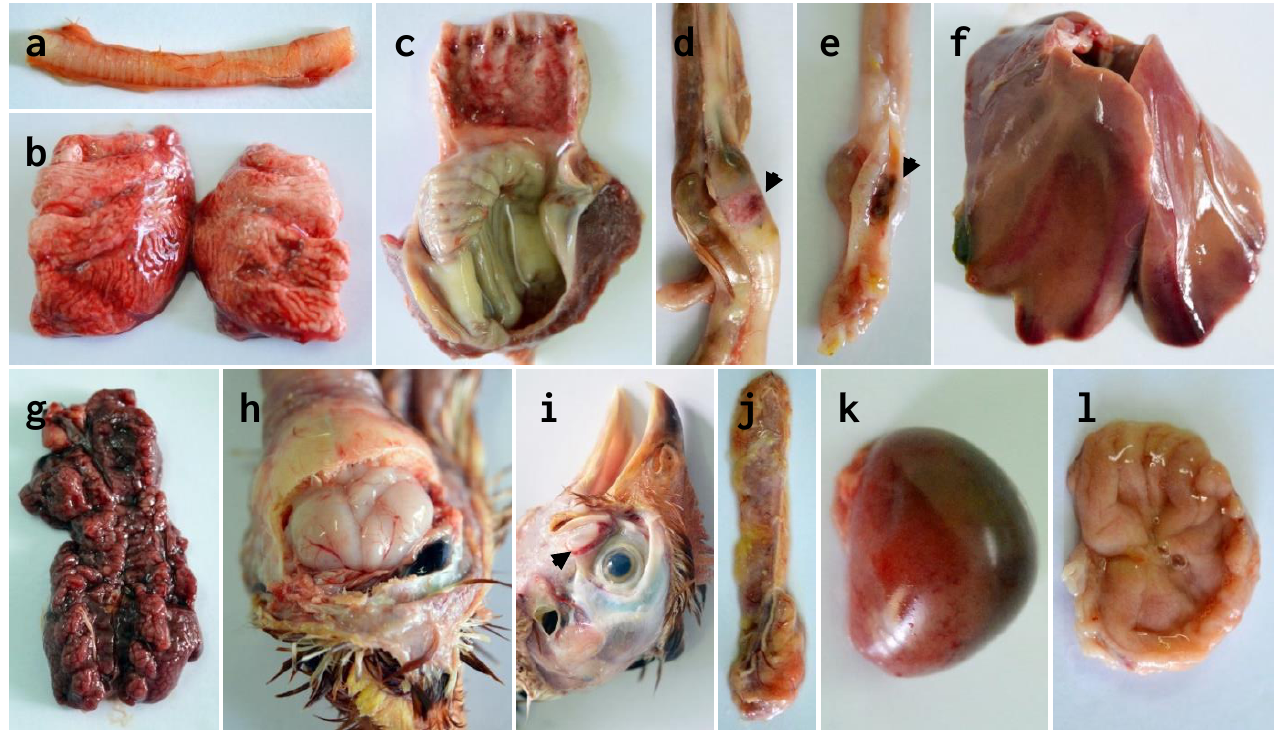
Figure 4. Gross pathological changes in chickens experimentally inoculated with LT67 isolates of NDV. ( a ) Hemorrhages in the trachea, ( b ) congestion in the lungs, ( c ) hemorrhages in the proven- triculus, ( d ) hemorrhages in the intestines (button-like ulcers), ( e ) € hemorrhages in the cecal tonsils, ( f ) congestion in the liver, ( g ) severe congestion in the kidneys, ( h ) congestion in the brain, ( i ) hem- orrhages in the Harderian glands, ( j ) hemorrhages and atrophy in the thymus, ( k ) congestion in the spleen, and ( l ) hemorrhages and slight atrophy in the bursa of Fabricius. The microscopic changes in the inoculated birds are presented in Figures 5 and 6.